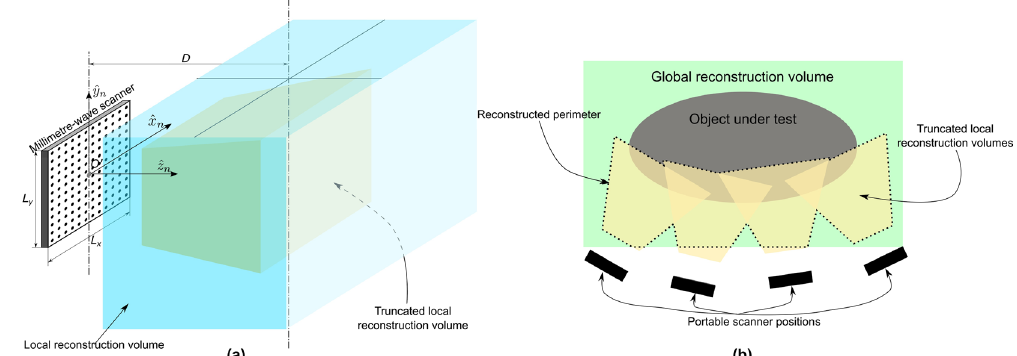
Figure 3. Reconstruction volumes involved in the proposed approach: ( a ) local reconstruction volumes and their corresponding truncated volume; ( b ) Global reconstruction volume filled by merging the reflectivities computed in the truncated local reconstruction